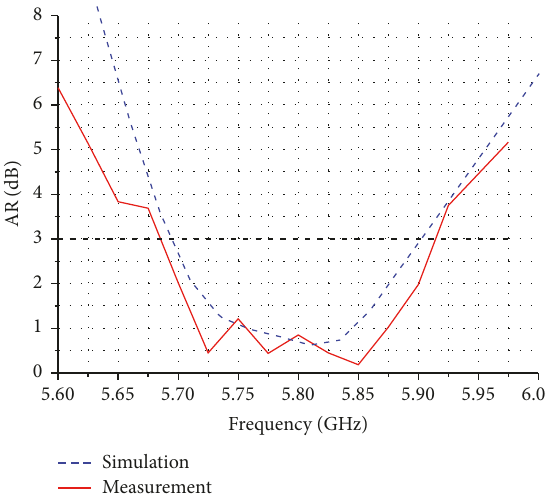
Figure 9: Measured and simulated AR of the 1 × 2 linear array.